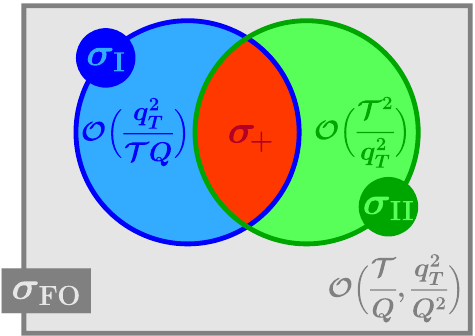
Figure 6 . Venn diagram of power corrections to the factorized double-di(cid:11)erential spectrum. SCET I (blue) and SCET II (green) each capture a set of power corrections that is expanded away in the SCET + factorization (red) and the opposite boundary regime. A third class of power corrections to the overall soft-collinear limit is captured by the (cid:12)xed-order calculation in full QCD